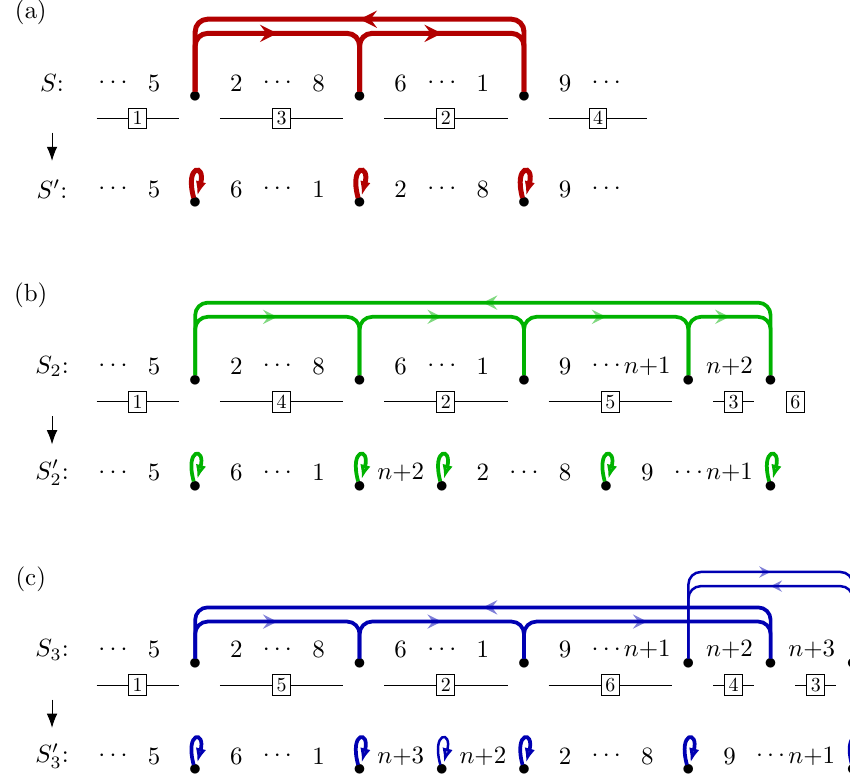
Figure 5. ( a ) The cycle ( 1,5,8 ) from Figure 4, and how solving it affects the rest of the sequence (substrings 2 8 and 6 1, i.e., blocks 3 and 2 are swapped). ( b ) The 2-extension of S for − − breakpoint x = 1, giving cycle ( 1, n + 1, n + 2,5,8 ) . This extended cycle can be solved with a 5-cut rearrangement having an equivalent effect on the sequence (substrings 2 The resulting S (cid:48) is the 2-extension of S (cid:48) for adjacency x = 1. ( c ) The 3-extension of S for breakpoint 2 x = 1, giving cycles ( 1, n + 2,5, 8 ) and ( n + 1, n + 3 ) (the latter being tied to the former: there is no way of solving breakpoint n + 3 without cutting n + 2). These two cycles can be solved with a 6-cut rearrangement having an equivalent effect on the sequence (again, substrings 2 swapped). The resulting S (cid:48) is the 3-extension of S (cid:48) for adjacency x = 3